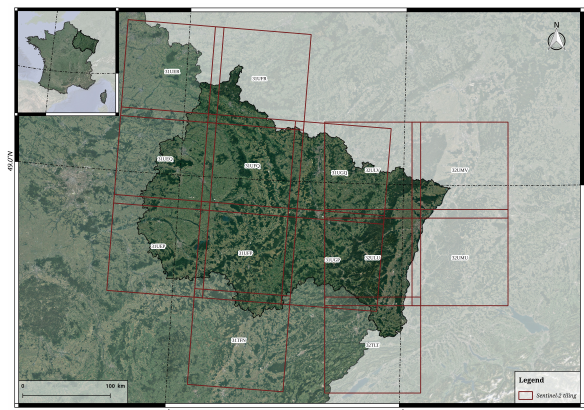
Figure 1. Study area with Sentinel-2 tiling grid.